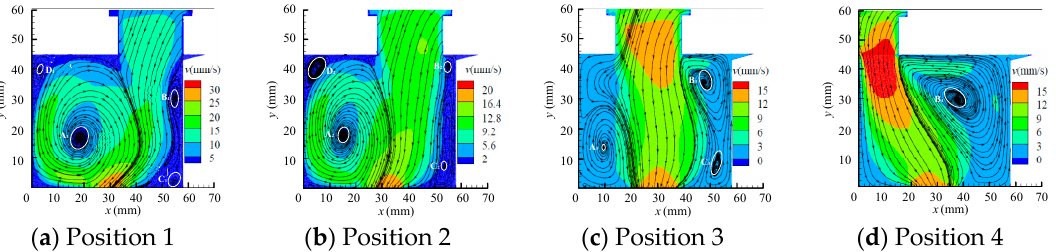
Figure 9. Velocity contours and streamlines with a piston moving speed of 3.7 mm/s.